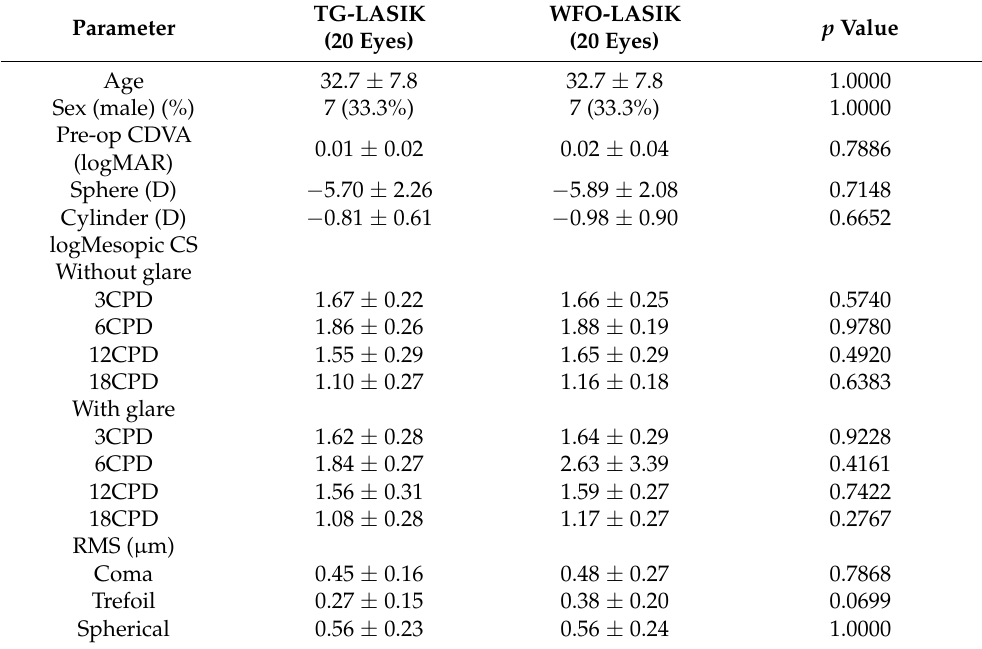
Table 1. Preoperative demographics, visual acuity, contrast sensitivity, and corneal wavefront aberration between the two groups.